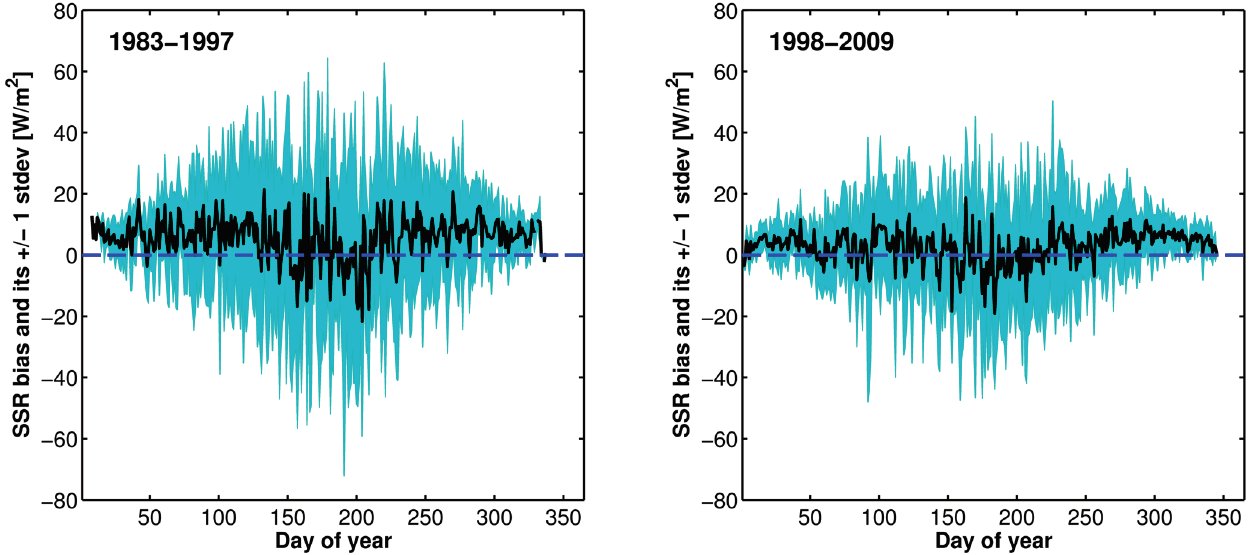
Figure 5. The annual cycle of the multiyear-averaged daily mean SSR bias (black) and its ±1 standard deviation (cyan) over Växjö station for 1983–1997 ( Left ) and 1998–2009 ( Right